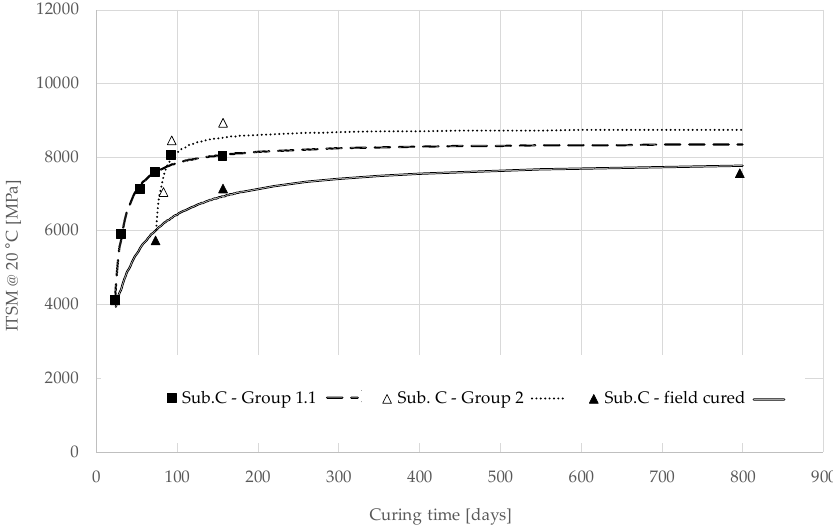
Figure 11. Measured data and model of the evolution of ITSM over curing time for core specimens of Subsection C: Group 1.1, Group 2 and field curing. Table 10. Estimated values of the regression parameters and air voids content of specimens of Group 0, Group 1.1, Group 2 and field curing.